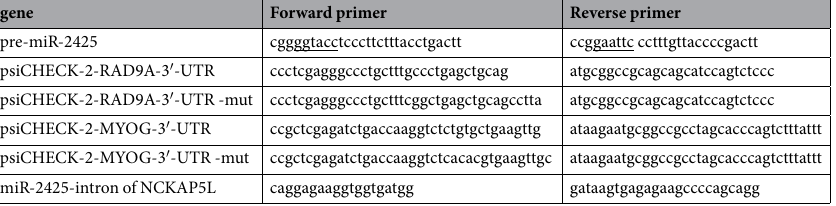
Table 2. Primers used for plasmid